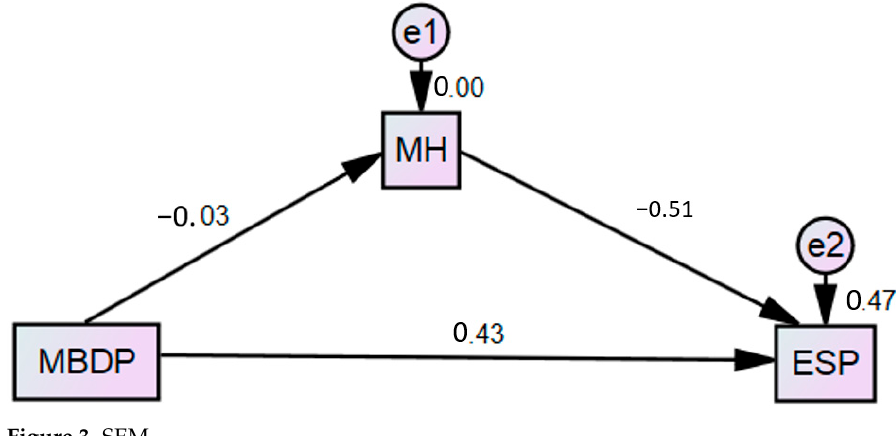
Figure 3. SEM. Figure 3. SEM.